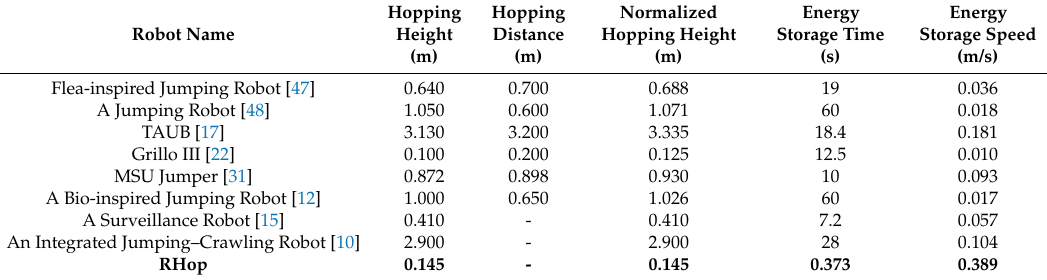
Table A2. Specific calculation